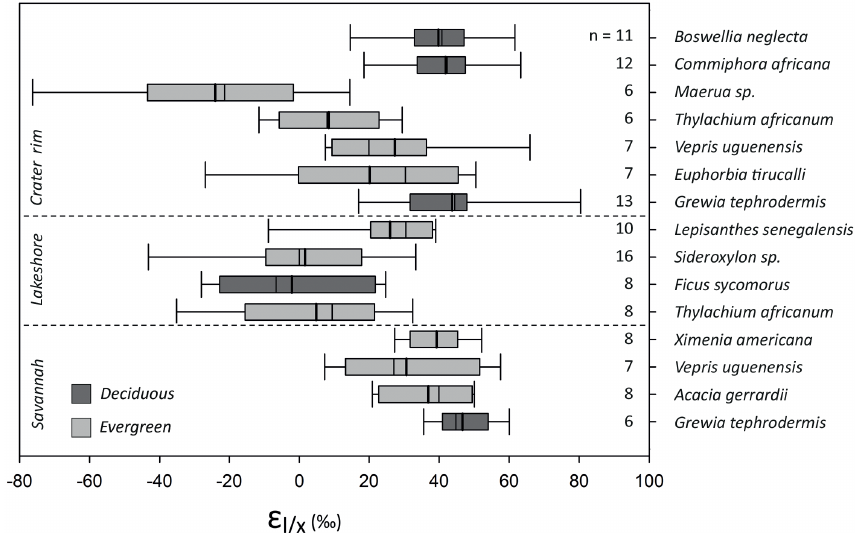
Figure 6. δ 2 H enrichment factor ε l/x , characterizing the hydrogen-isotopic fractionation between xylem and leaf water, among habitat and leaf phenology. Deciduous plants gave higher ε l/x than evergreens. Note that Grewia tephrodermis , Vepris uguenensis and Thylachium africanum showed similar ε l/x independent of sample habitat. n : amount of